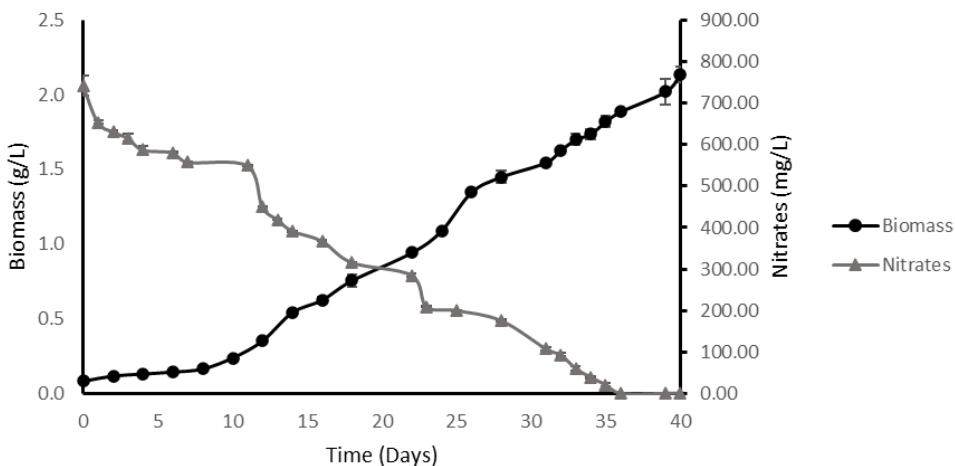
Figure 3. Growth kinetics of M. salina in high-density cultures. These cultures were made with a concentration of nitrates provided in the culture medium equal to 744 mg/L and 43.7 mg of initial phosphates. Growth curve is expressed in dry biomass (g/L) and dissolved nitrates (mg/L) as a function of time.